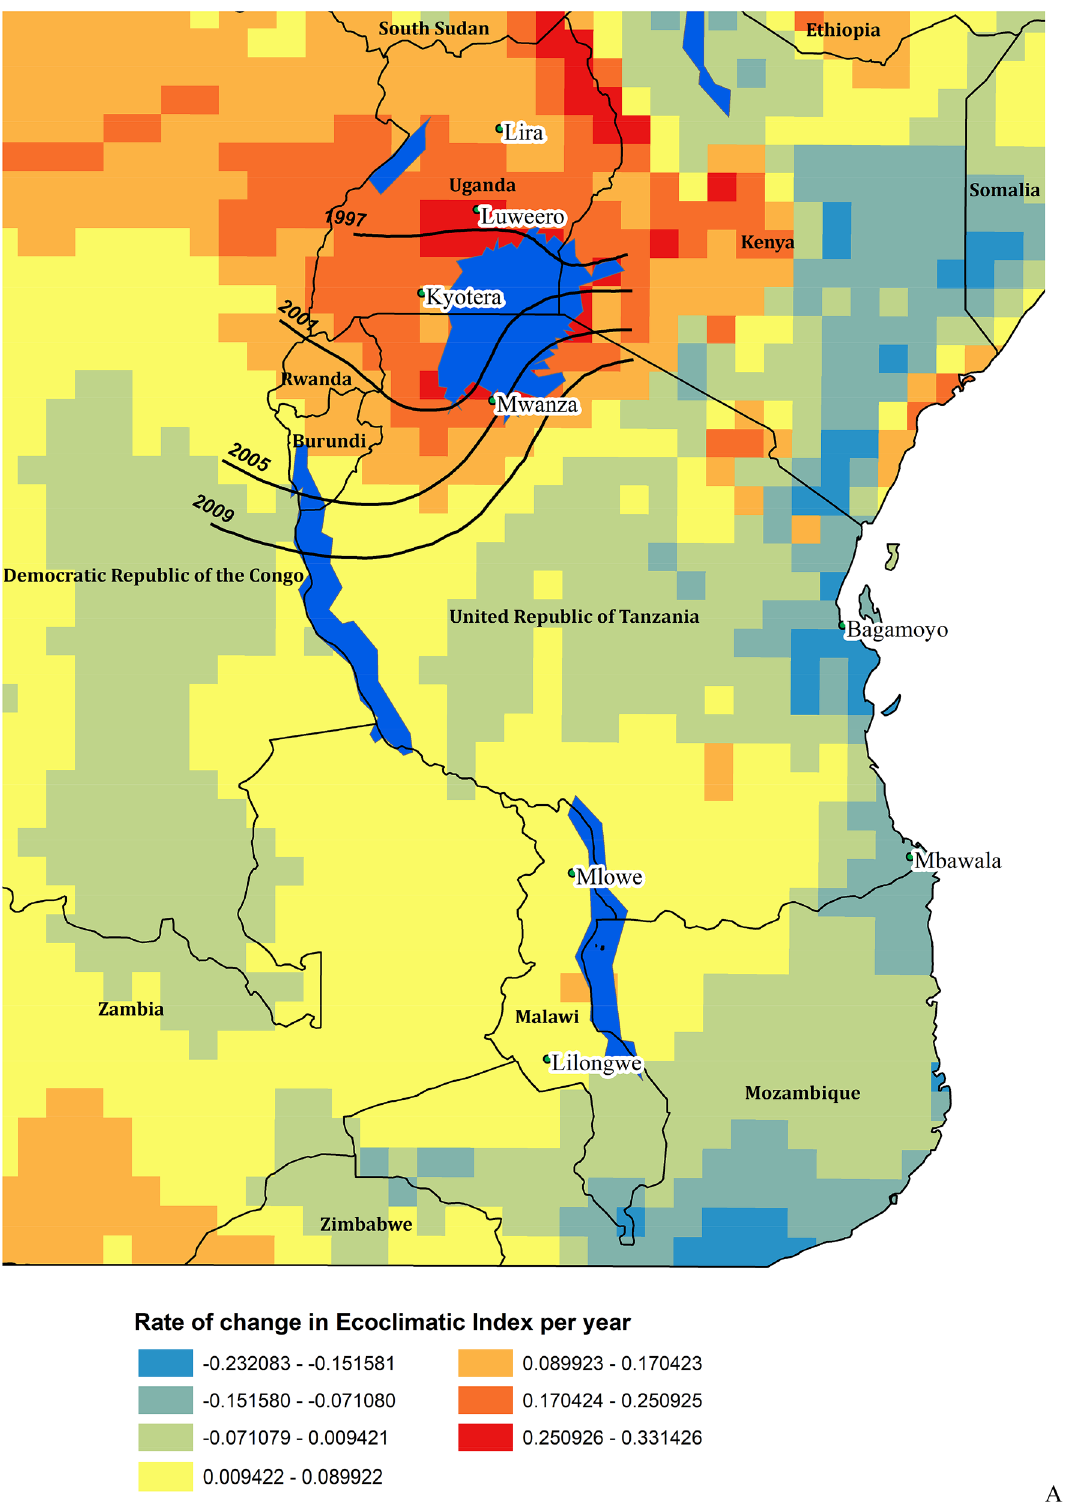
Figure 6. East and Central Africa showing changing climate suitability between 1979 and 2012 for Bemisia tabaci MEAM1 modelled using CLIMEX 53,64 running the CRU time series climatic dataset 77 . ( A ) average change in Ecoclimatic Index, and the probability of significance of Student’s t statistic for a regression of the time-series within each cell of the average change in Ecoclimatic Index for ( B ) positive trend, and ( C ) for negative trend. Maps produced using ArcMap 10.6 (ESRI, Redlands, Ca.,